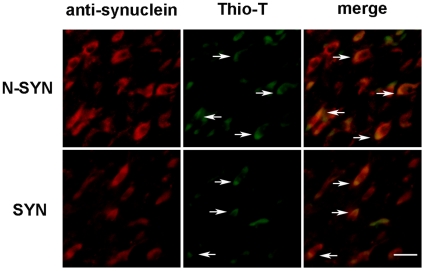
N-SYN and SYN can form intracellular aggregates in the substantial nigra.Anti-α-synuclein antibody (red) and Thioflavin-T (green) were applied to detect aggregation after N-SYN or SYN treatment. α-Synuclein positive intracellular aggregates, which were also Thioflavin-T positive, were formed after two weeks injection of N-SYN (arrows in upper panel). Similar aggregates were detected after two weeks injection of SYN (arrows in lower panel). Scale bar: 25 µm.